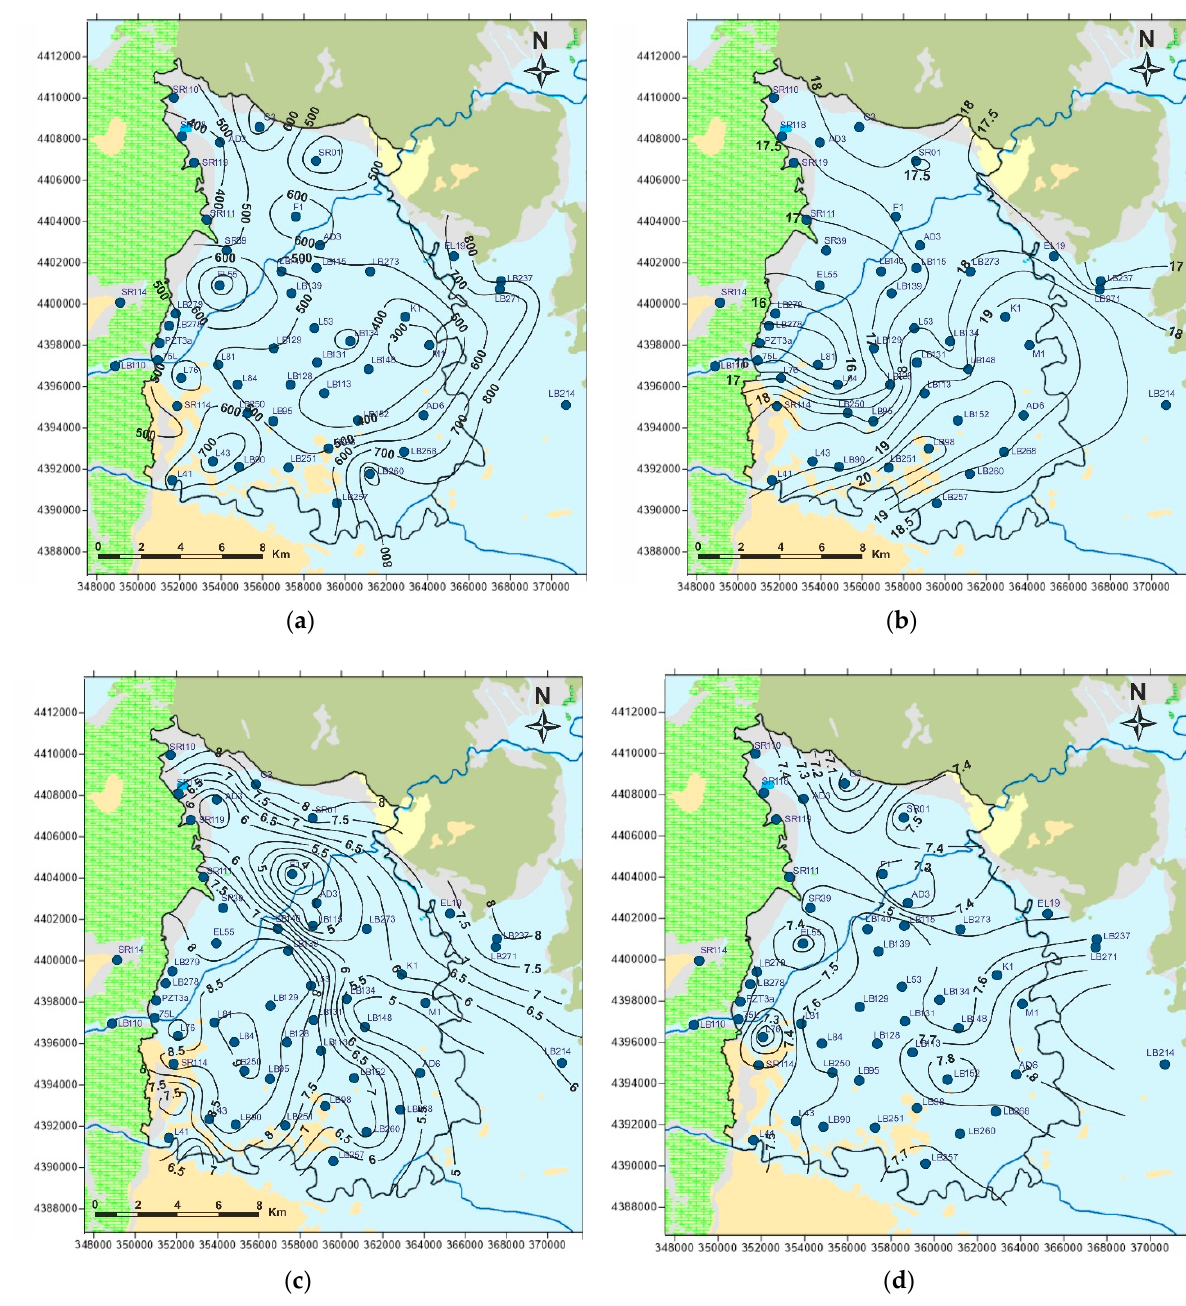
Figure 5. Spatial distribution of physicochemical parameters at the study area: ( a ) electrical conductivity ( µ S/cm); ( b ) water temperature (°C); ( c ) dissolved oxygen (mg/L); ( d ) pH.